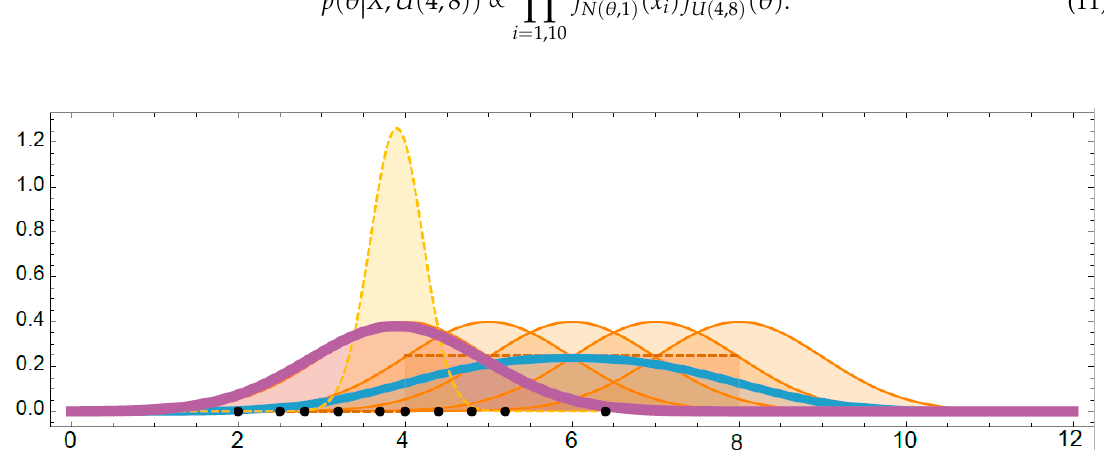
Figure 3. Illustration of obtaining the posterior distribution by updating the prior distribution using a sample of data.